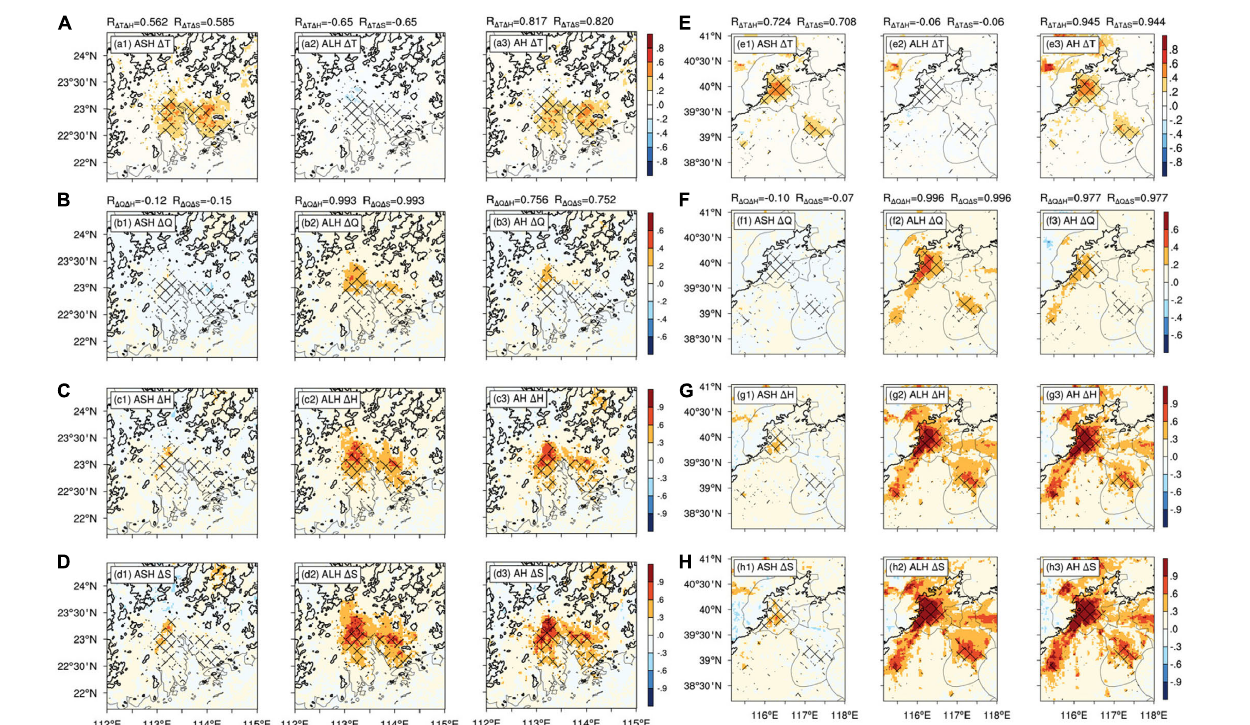
FIGURE 5 | The spatial distribution of moist enthalpy and moist entropy changes ( (cid:49) H and (cid:49) S ) and their pattern correlations with temperature and humidity change ( (cid:49) T and (cid:49) Q ) for group 1 experiment ( Table 2 ), taking account of the impact of AH and its components, and R at the top of each panel denotes the correlation coefficient between its two subscript variables. By taking the difference between Real run and the other three runs, we quantify the sole influence of ASH (Real–no ASH), ALH (Real–no ALH), and AH (Real–no AH) in south (A–D) and north (E–H) , where gridding by slash line represents urban